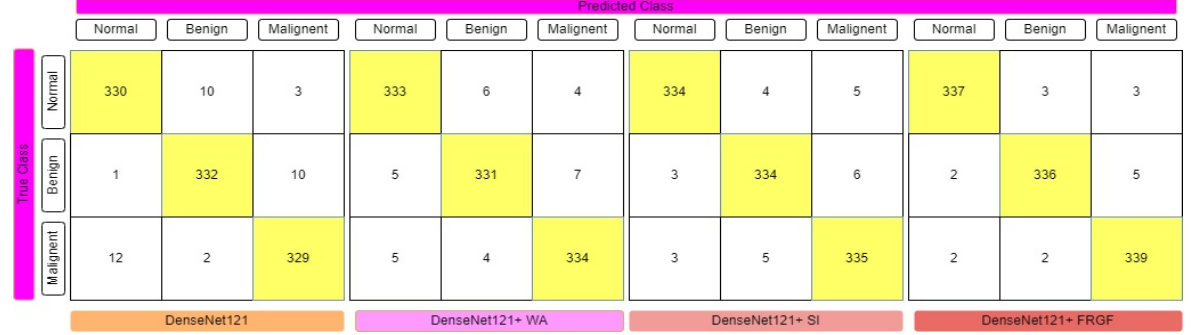
Figure 10. Confusion matrix representation of VGG-11 deep CNN model with various fuzzy ensemble technologies. VGG-11, VGG-11+ WA, VGG-11+ SI, and VGG-11+ FRGF showed 96.21%, 96.70%, 97.08%, and 97.67% accuracy, respectively.